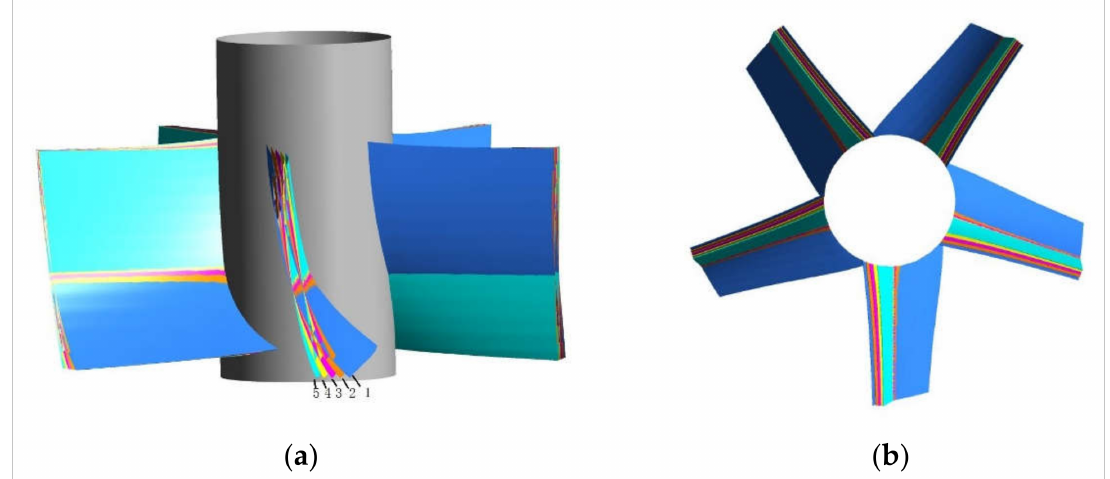
Figure 8. Guide vane models with different design parameters. ( a ) Front view of guide vane. ( b ) Top view of guide